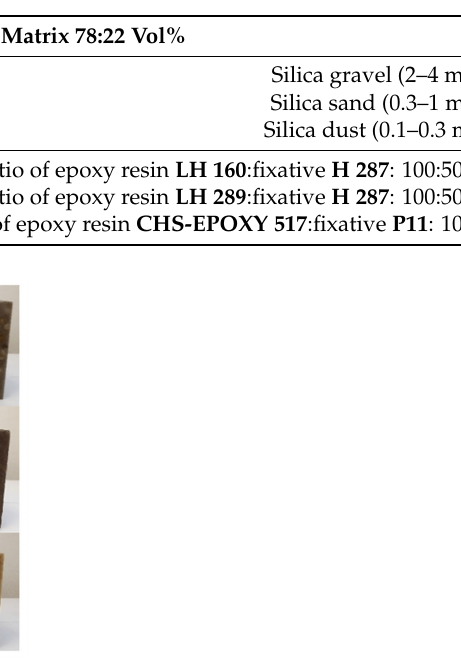
Table 3. Descriptions of Samples G–I with different epoxy resins and constant fillers mixture.